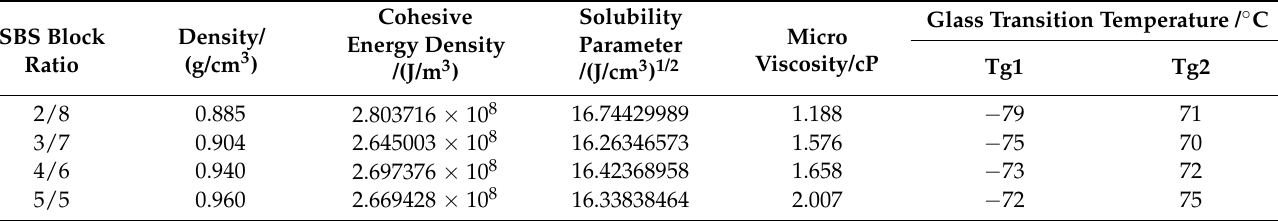
Table 3. Basic properties of SBS with different block